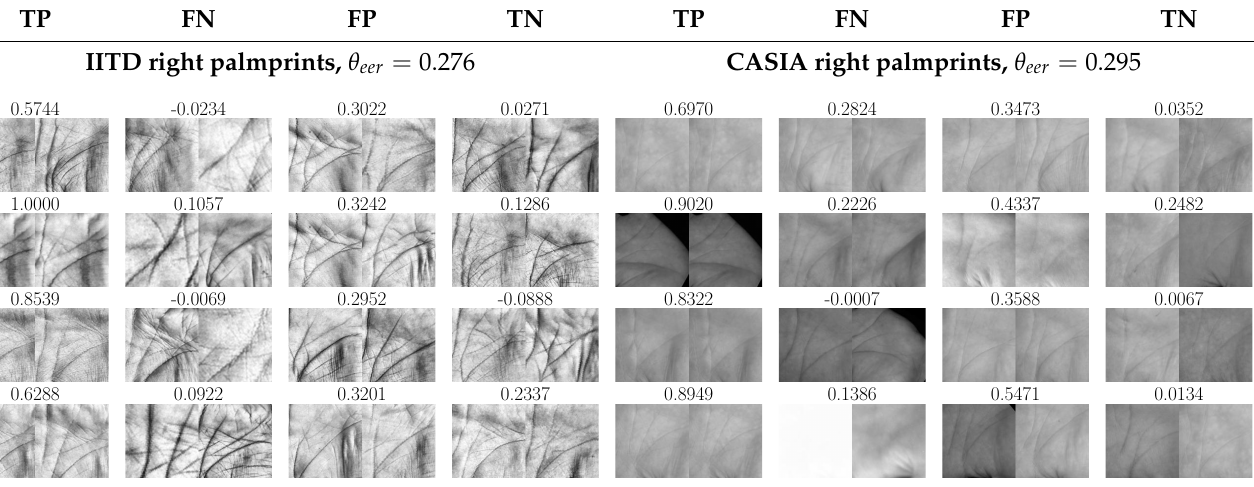
IITD left palmprints, θ eer = 0.259